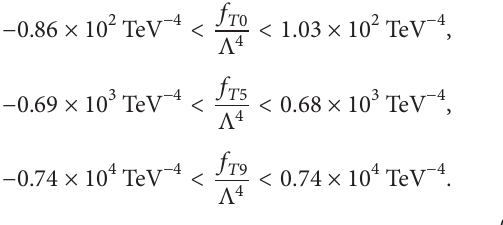
cross section for the subprocess 𝛾𝛾 ∗ → 𝑍𝑍 over the 𝛾 ∗